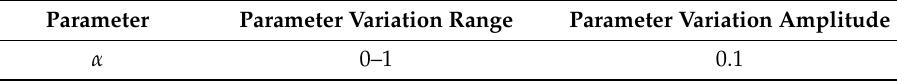
Table 3. Parameters of Scenario 2.